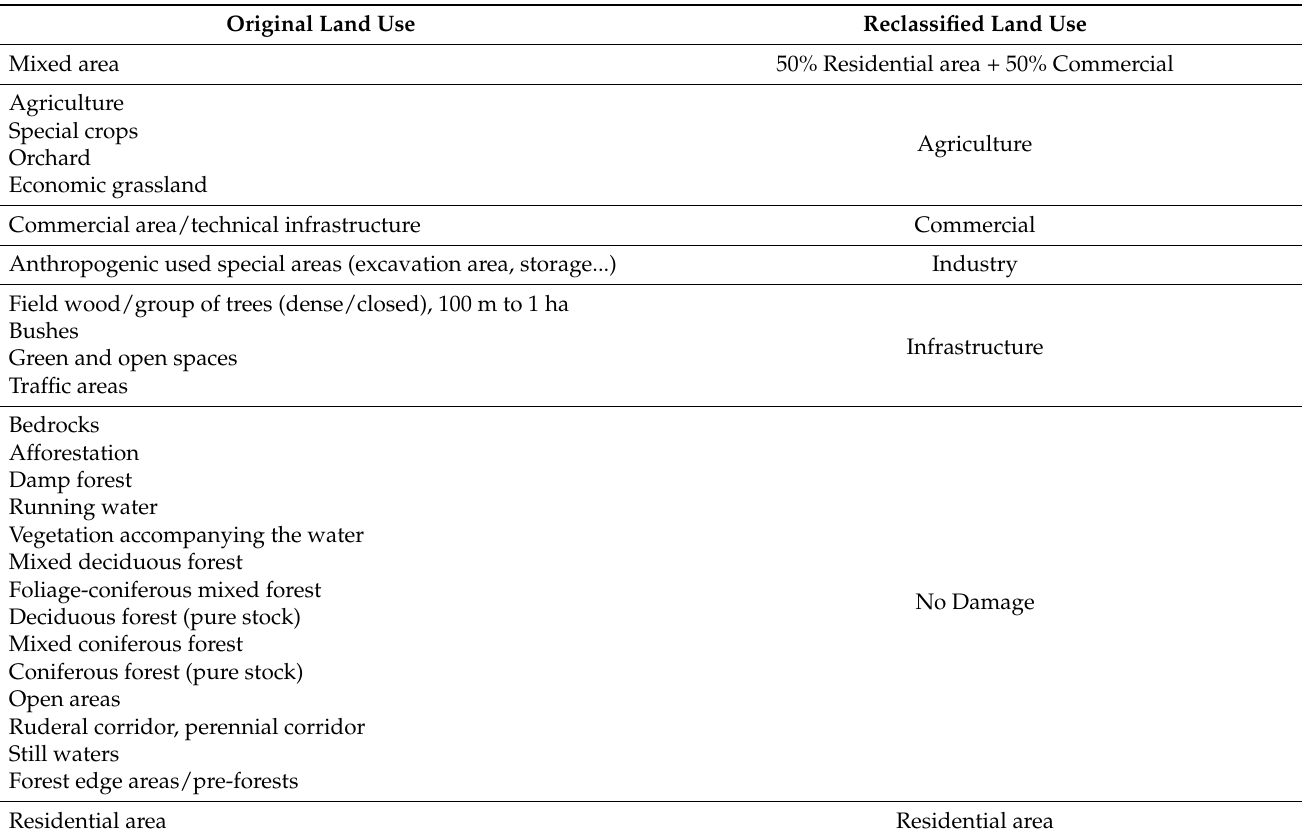
Figure A1. Land use classes in the study area (adapted from [13]).